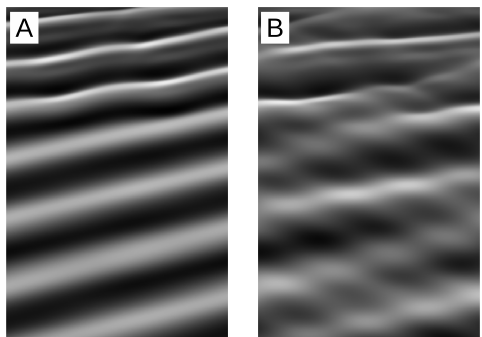
Figure 10. Initial snapshots for synthetic nonlinear wave trains W1 ( A ) and WS ( B ) for F = 2.5: Spatial domain is 200 m × 300 m (in the alongshore and cross-shore directions), and pixel intensity is a linear function of the modelled free surface elevation.